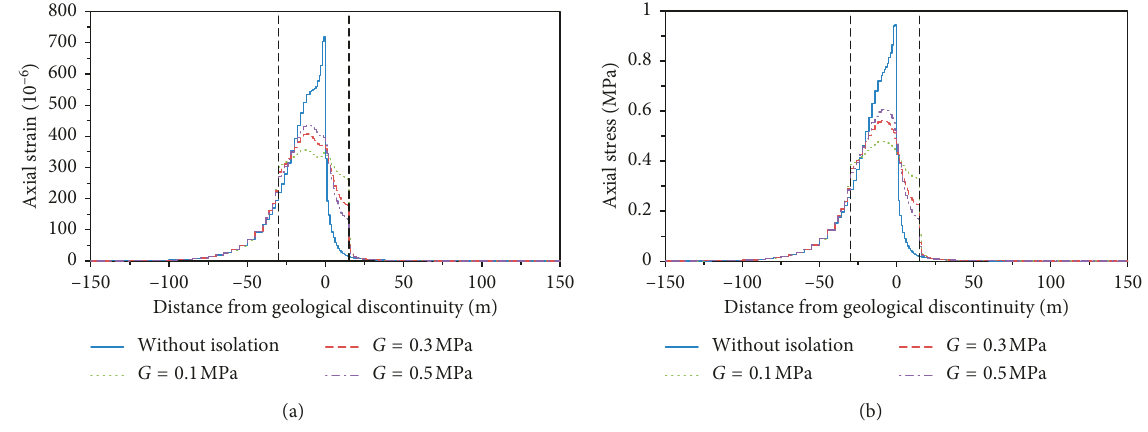
Figure 14: Analysis results along the longitudinal direction. (a) Axial strain and (b) axial stress. Table 4: Decrease rate of axial peak strain and stress corresponding to different shear moduli. Elastic modulus (MPa) Decrease rate of peak strain (%) Decrease rate of peak stress (%)